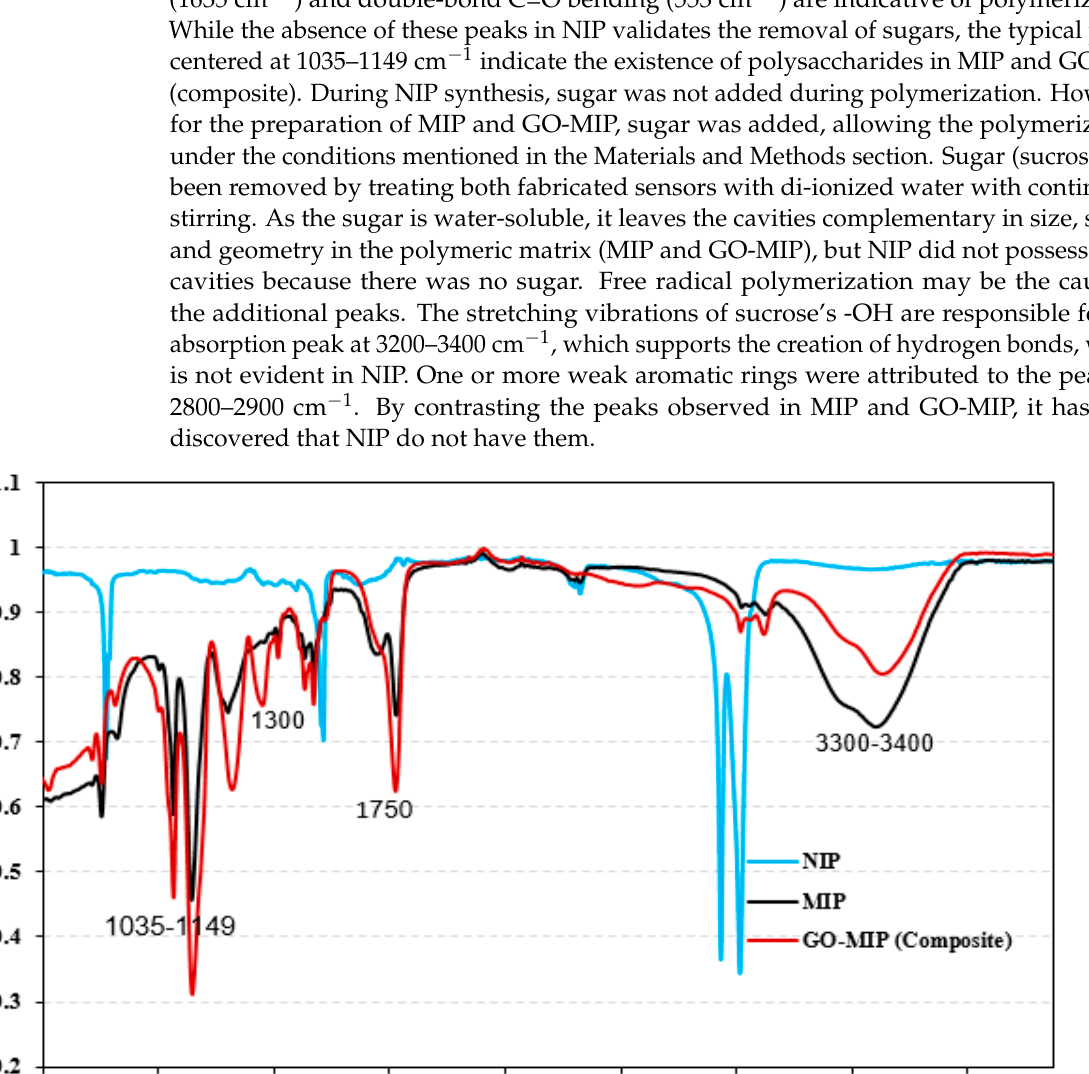
21.12 ◦ C to 339.49 ◦ C. The second weight loss of 2.515 mg has occurred between 339.47 ◦